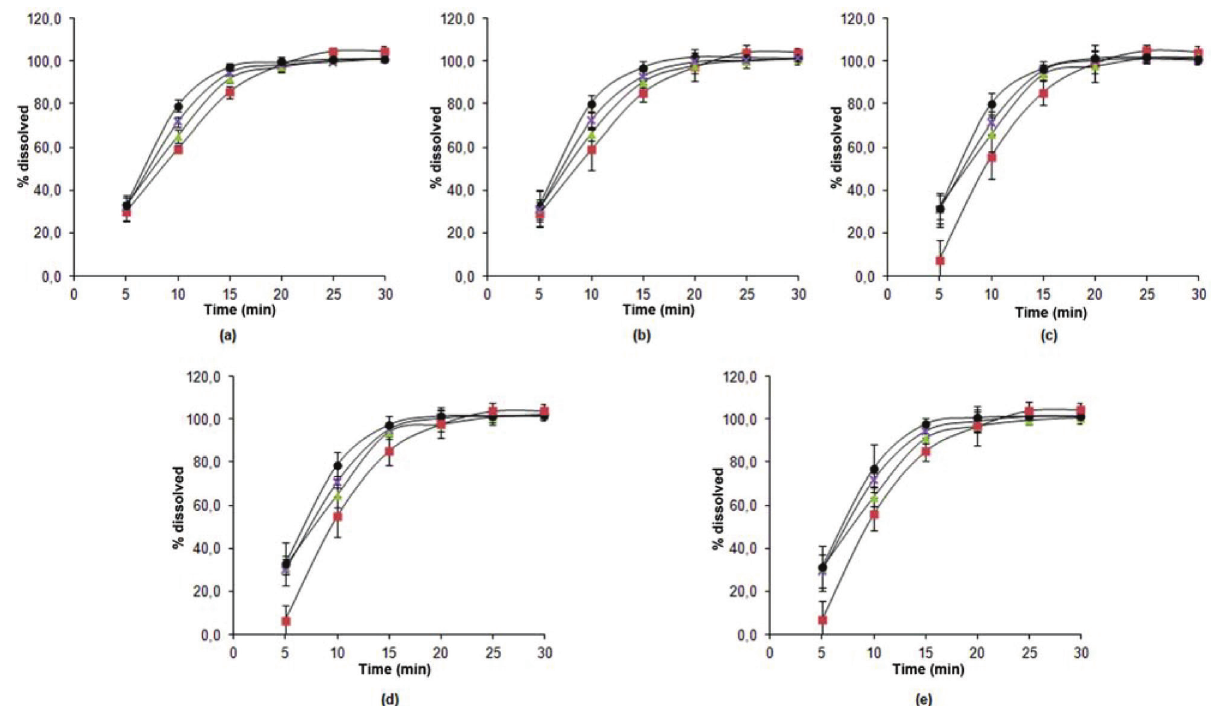
FIGURE 8 – Dissolution profiles of prednisone tablets for batches R023(■), P0020020910 (●), MEST01 (▲), and MEST02 (x) at times (a) 0, (b) 90, (c) 180, (d) 270 and (e) 360